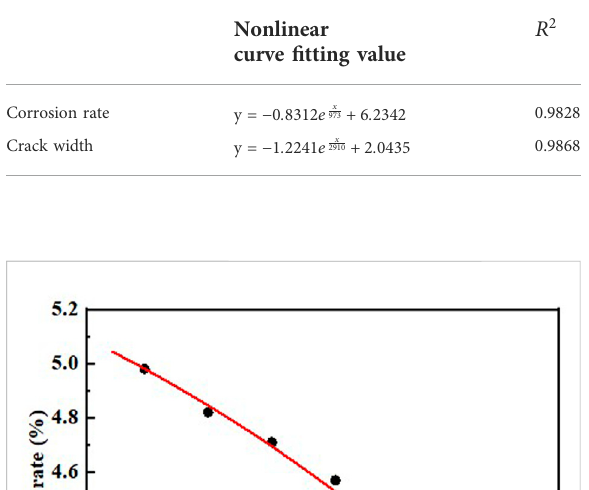
FIGURE 2 Corrosion rate with time.